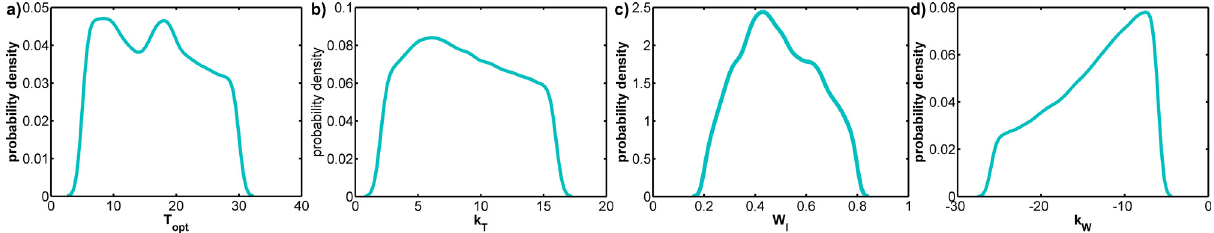
Fig. 6. Probability density functions (PDF) resulting from the Monte Carlo sensitivity study ( N =750000) for the proposed model in which all seven constant model parameters could vary freely. The PDFs are drawn for the best solutions (1%) over all sites (with regard to the sum of squared errors between measured and modelled F G time series) for the four parameters of the subfunctions ( f T , f W ): T opt (a) , k T (b) , W I (c) , k W (d) . In the final model calibration, k W is set constant.